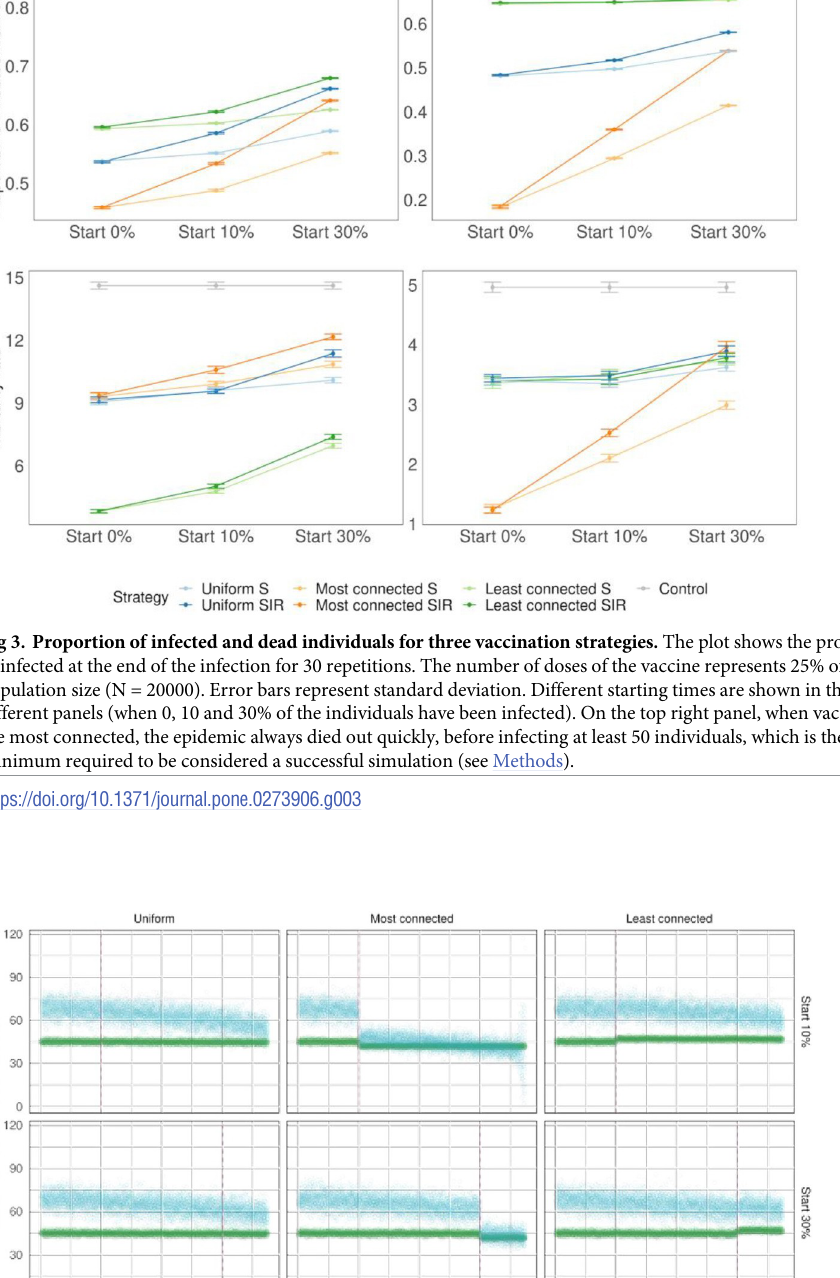
PLOS ONE | https://doi.org/10.1371/journal.pone.0273906 September 1,